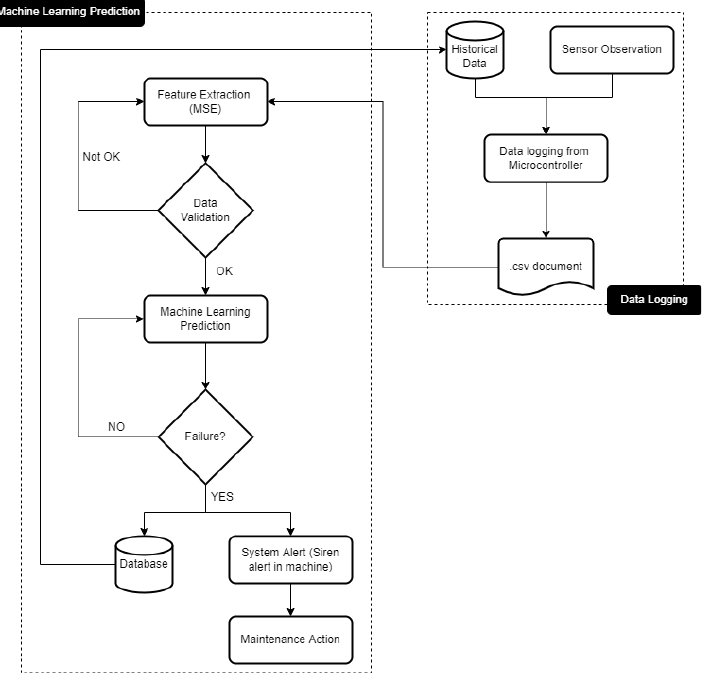
Figure 7. Flow diagram of data logging and predictive maintenance using machine learning. The flow diagram shows that the system is started from a data logging mechanism. Algorithm 1. Data Logging